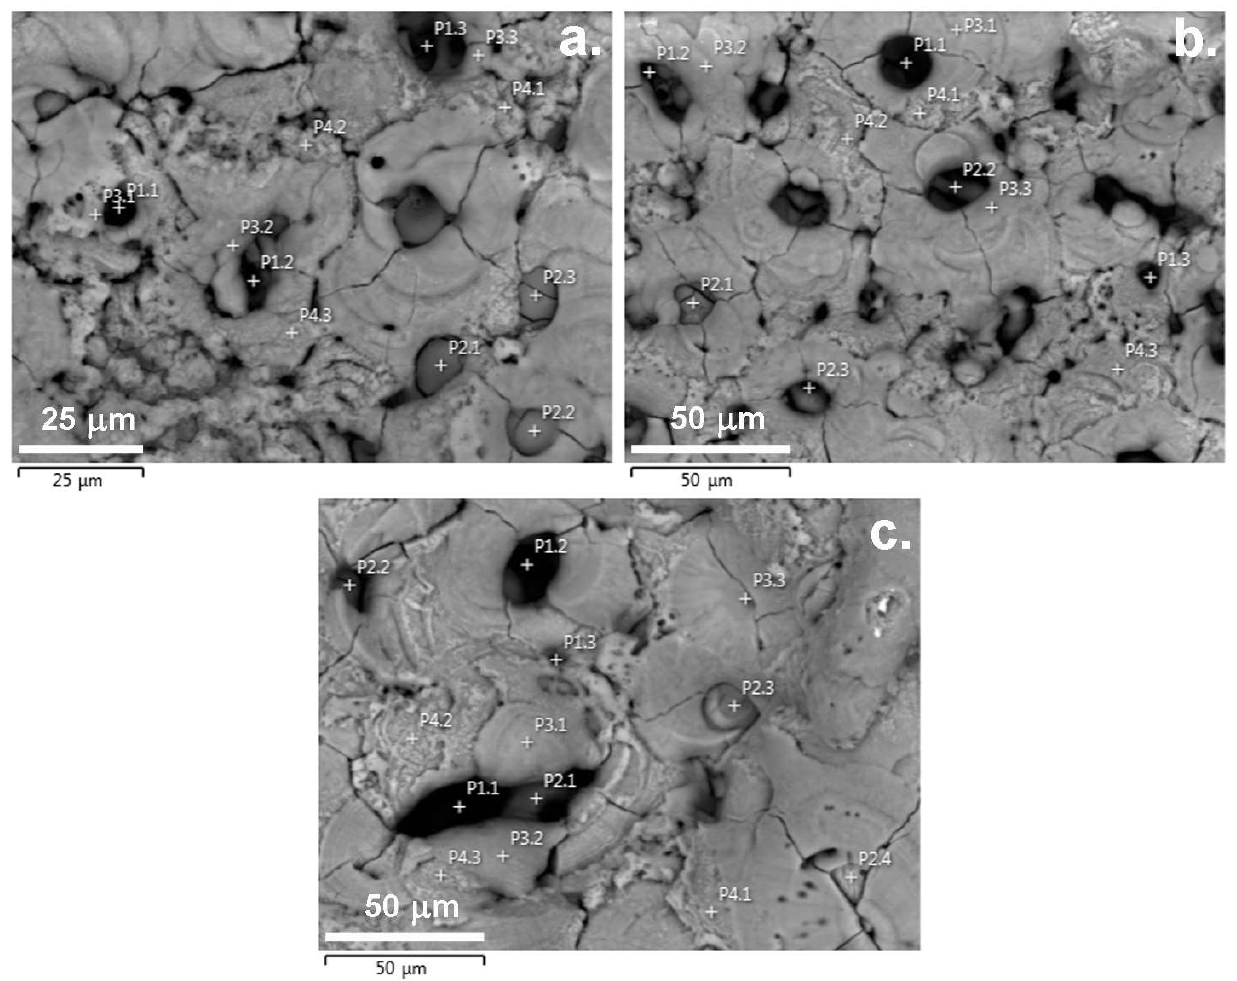
Figure 5. Surface point-scans EDS analysis on “pancake-like” areas: P1—deep pore; P2—shallow pore; P3—re-solidified melt pool; P4—sintered particles for AZ63_5m ( a ), AZ63_10m ( b ) and AZ63_20m ( c ) samples.